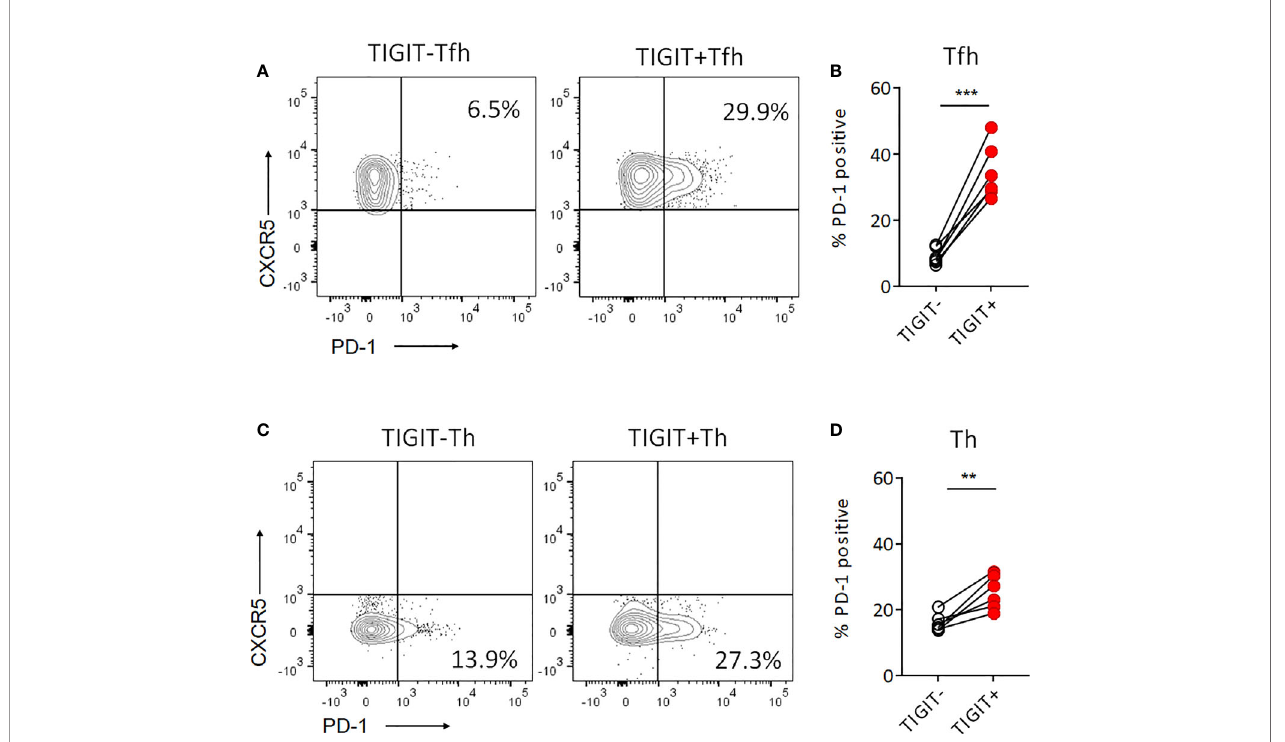
FIGURE 5 | Proportion of PD-1 + cells is higher in TIGIT + T cells than TIGIT - T cells. (A, B) PD-1 expression level was examined in TIGIT + Tfh and TIGIT - Tfh cells by fl ow cytometry. (C, D) PD-1 expression level was examined in TIGIT + Th and TIGIT - Th cells by fl ow cytometry. (A, C) , representative image. (B, D) , multiple comparison results (n=6). (B, D) paired t-test. ***p<0.001, scores (mean 15 versus 10, p<0.01) and levels of serum IgG (mean 2120mg/dL versus 1551mg/dL, p<0.01) ( Supplementary ( Figure 8B ). There was no signi fi cant correlation between the Figure 8 ), and serum IgG4 level tended to be higher in group 4 proportion of TIGIT+ Tfh1 cells and clinical parameters than group 3 (752mg/dL versus 440mg/dL, p=0.07) ( Figure 8B ). ( Supplementary Figure 8 ). Collectively, the increased